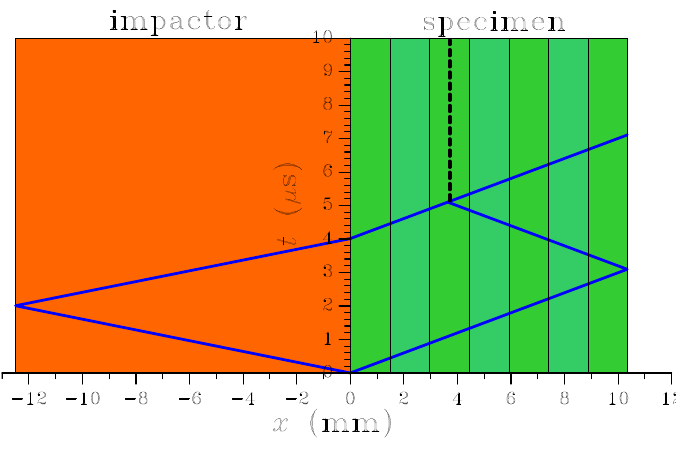
Figure 3. Impact on a 7-layer composite [13]: space-time diagram (the vertical dashed line here represents the possibly debonding surface of a brittle, homogeneous